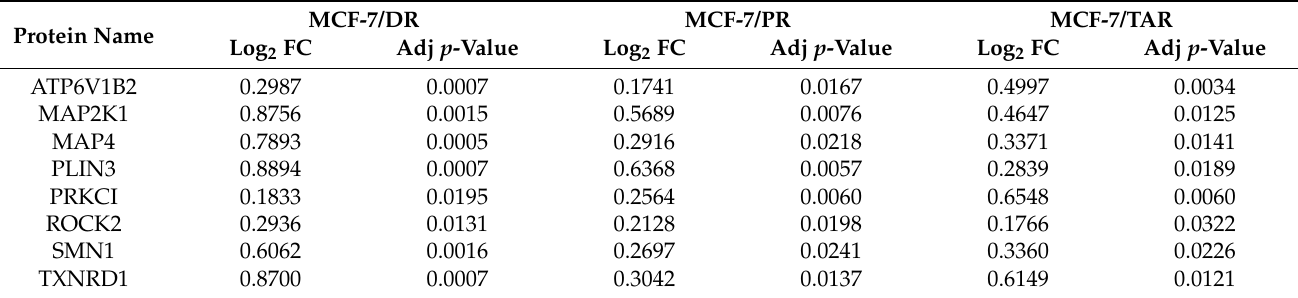
Table 1. Representative relative expression levels of protein between parental MCF-7 and drug- resistant